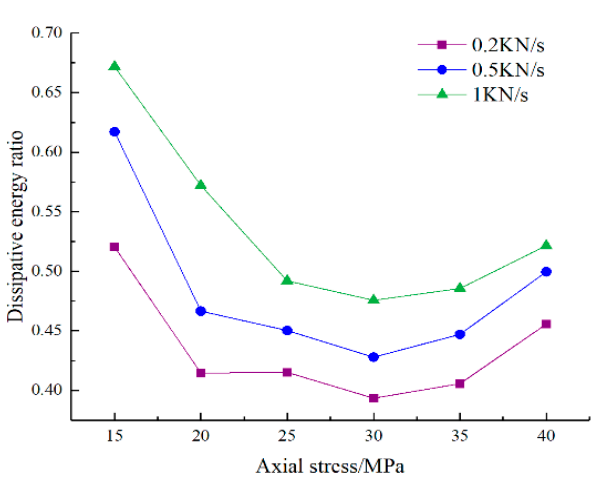
Figure 11. Dissipation energy proportion curve.